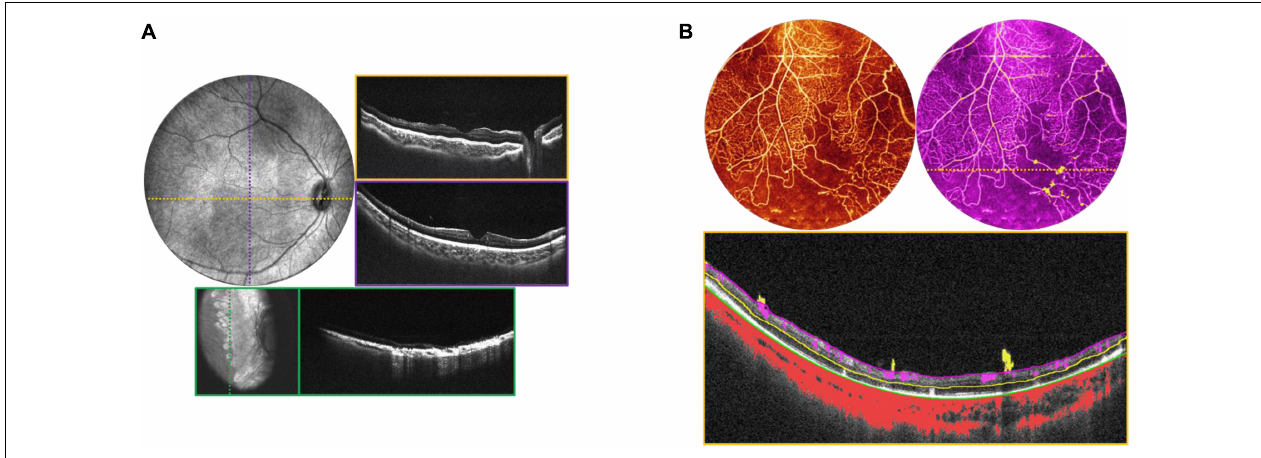
FIGURE 8 | Incontinentia pigmenti (IP). (A) OCT volume of a 1-year-old with IP. Top left image is the OCT 55 ◦ FOV en face projection. Corresponding color-coded B-scans at top right show irregularities in the nerve fiber layer and retinal surface. Bottom image in teal shows the retina after laser treatment, with en face view on the left, and corresponding B-scan on the right. (B) OCTA evaluation of a 2-year-old patient with IP. Top left image shows the OCTA en face projection with 55 ◦ FOV, while top right image shows the same volume with extraretinal neovascularization highlighted in bright yellow. Bottom image is the B-scan corresponding to the dashed yellow line above, showing automated segmentation of capillary plexus layers.